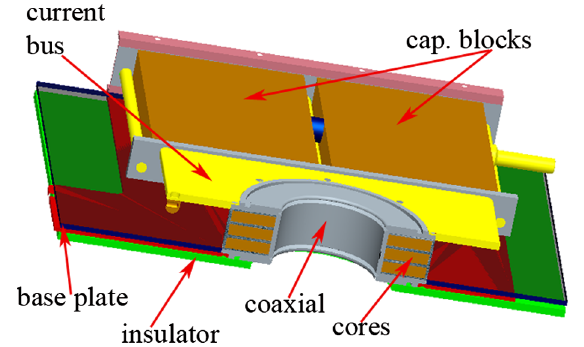
FIG. 5. Half cutview of LTD-4 stagewith main elementsshown.